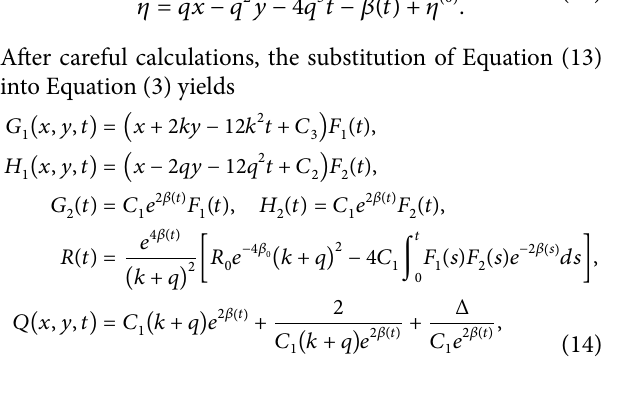
Figure 2: Mixed RE solution of the KPIIESCS for